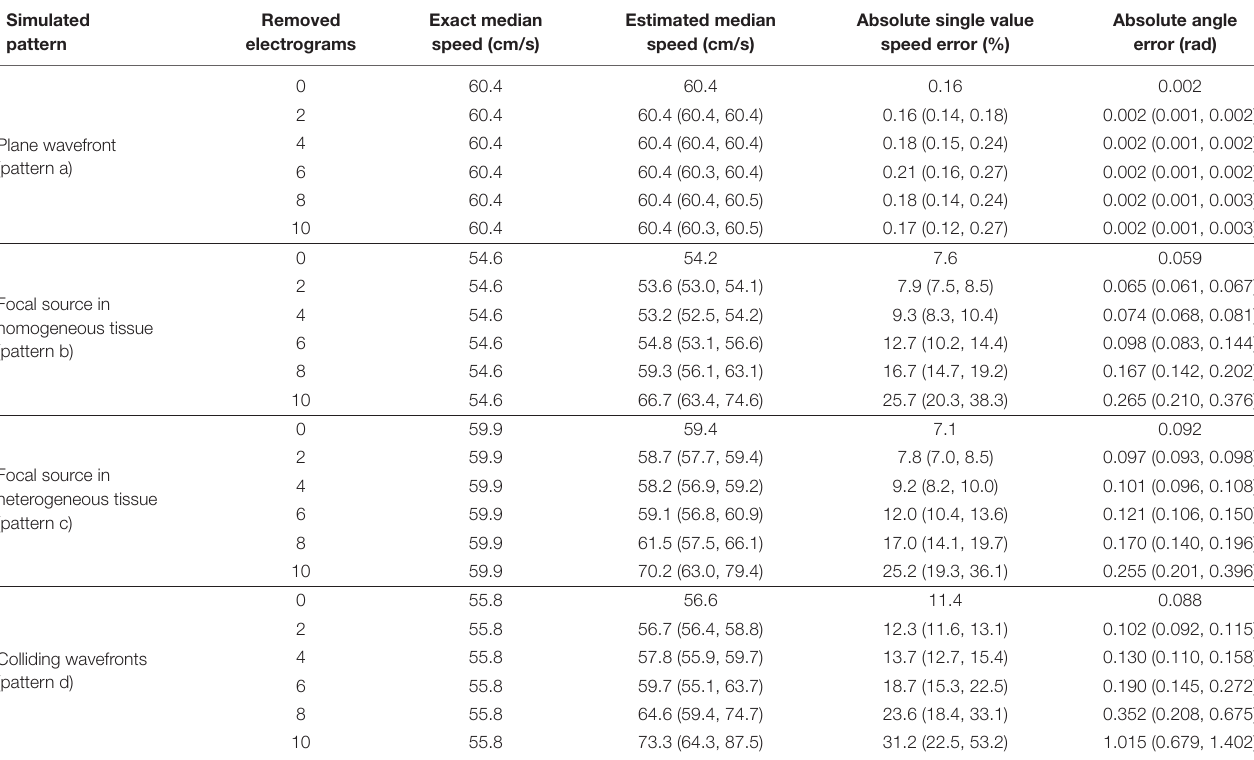
TABLE 1 | Effects of electrogram removal on the estimation of median velocity, velocity vector magnitudes, and directions. Simulated